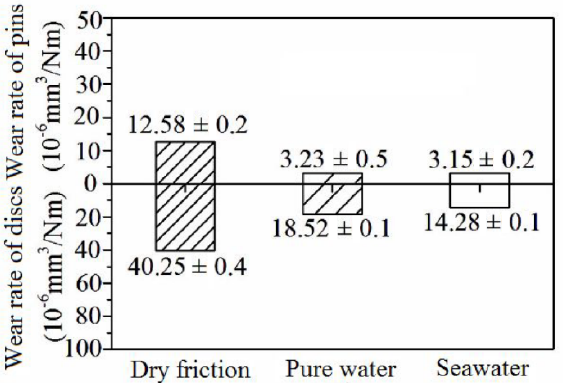
Figure 4. Wear rates of the SN10/GCr15 tribopair under different lubrication conditions.